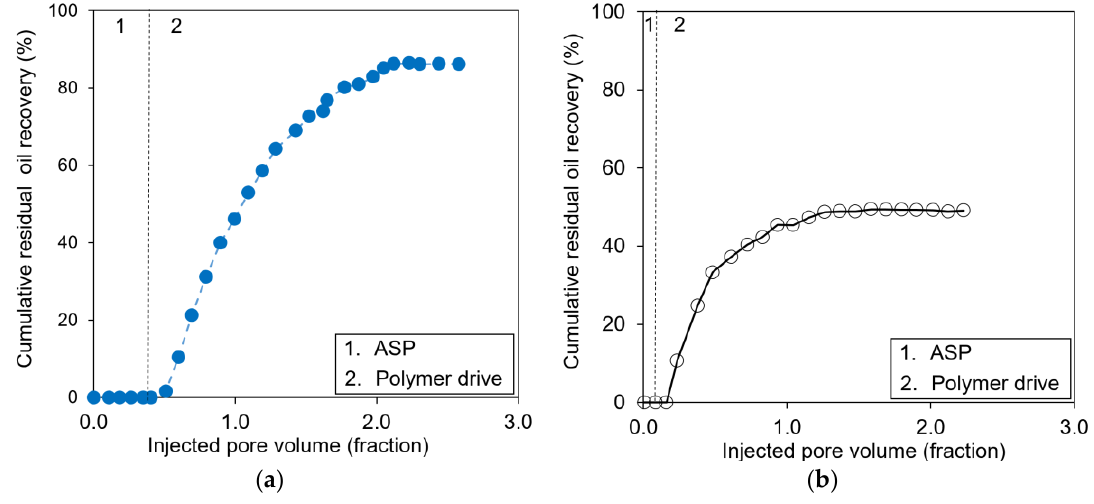
Figure 5. Cumulative residual oil recovery implementing ASP flooding with different injection volumes of ASP slug: ( a ) an injected PV of 0.37 and ( b ) an injected PV of 0.10. The vertical dashed line represents the end of the ASP mixture injected into the core sample.